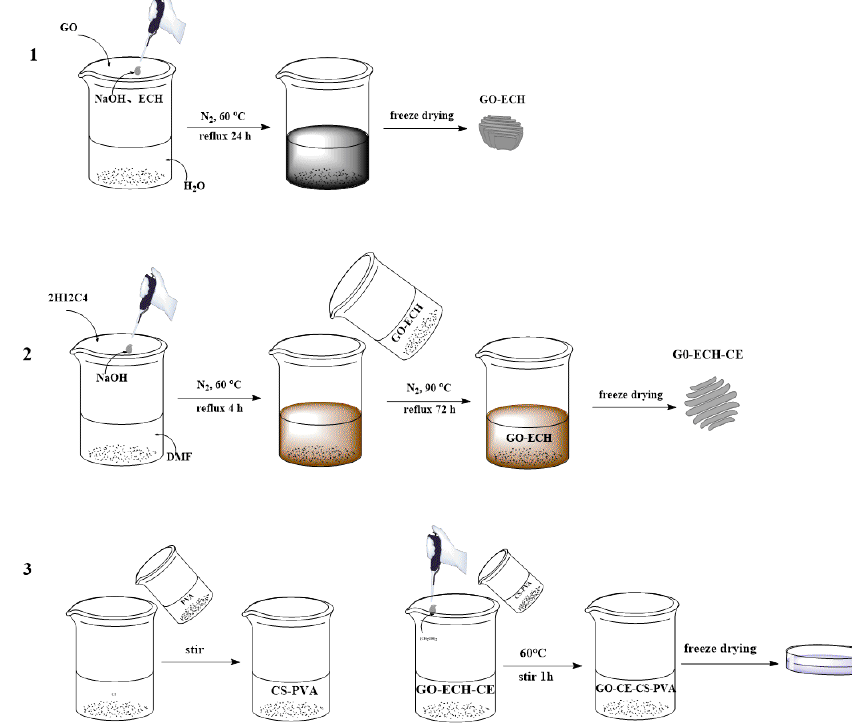
Figure 1. Experimental flow chart.